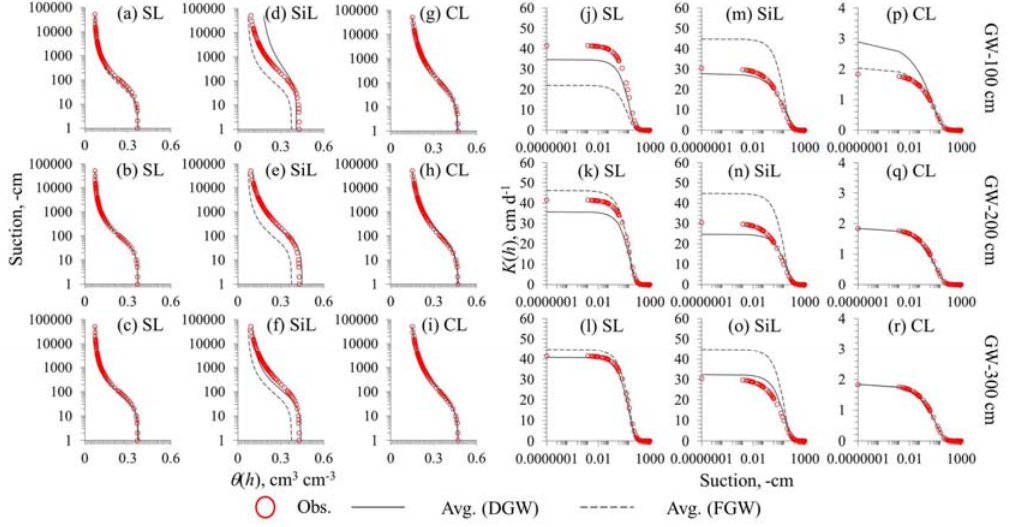
Figure 4. Comparison of observed and ensemble averaged water retention ( θ ( h )) and hydraulic conductivity (K( h )) curves with shallow ground water table depths of − 300, − 200, and − 100 cm with different soil textures. SL: sandy loam; SiL: silt loam; CL: clay loam. Number in ensemble: 100.